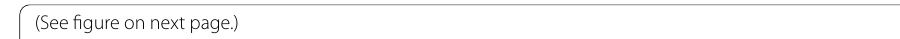
figure on next Fig. 7 SNHG3 influences growth of solid tumor and methionine dependence of PCa in nude mice. A Tumor image and tumor weight dissected from nude mice 35 days later (N (N 3, * p < 0.05); C , D SNHG3, miR-152-3p, and SLC7A11 levels in tumor tissue were assessed via qRT-PCR = and western blot. The experiment was repeated 3 times, * p < 0.05; E percentage of Ki-67 positive cells in xenogeneic tumor tissue assessed by IHC (scale bar: 50 μm). The experiment was repeated 3 times, * p < 0.05; F tumor weight ratio of nude mice at terminal stage with a normal diet or a diet lacking MET (MET-HCY diet) (N 3, * p < =